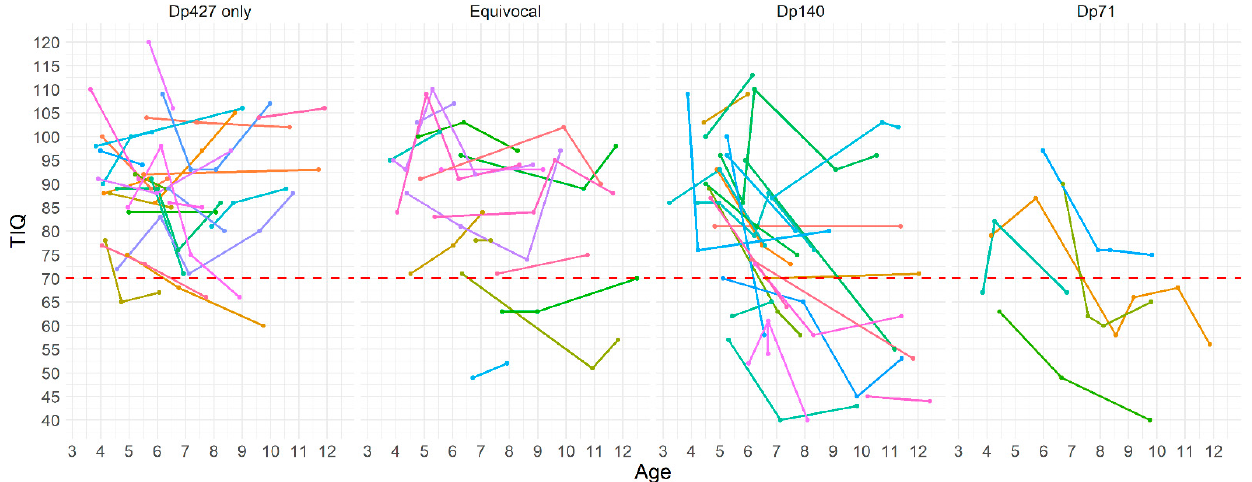
Figure 5. Individual IQ changes in patients subdivided according to brain dystrophin isoform involvement: Dp427 only, equivocal, Dp140, and Dp71. Key to figure: dashed red line TIQ = 70, each colored line represent an individual patient.